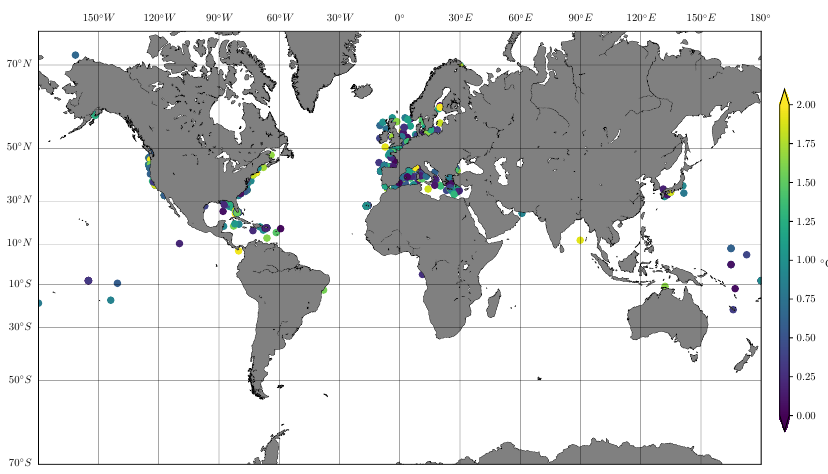
Figure 4. Temperature interpolation. Training : predicted vs. in situ data ( top left ); histogram of residuals in training ( top right ). Test : predicted vs. in situ data ( centre left ); histogram of residuals ( centre right ); difference between measured and predicted temperature in test locations ( bottom ). Units of temperature are ◦ C.